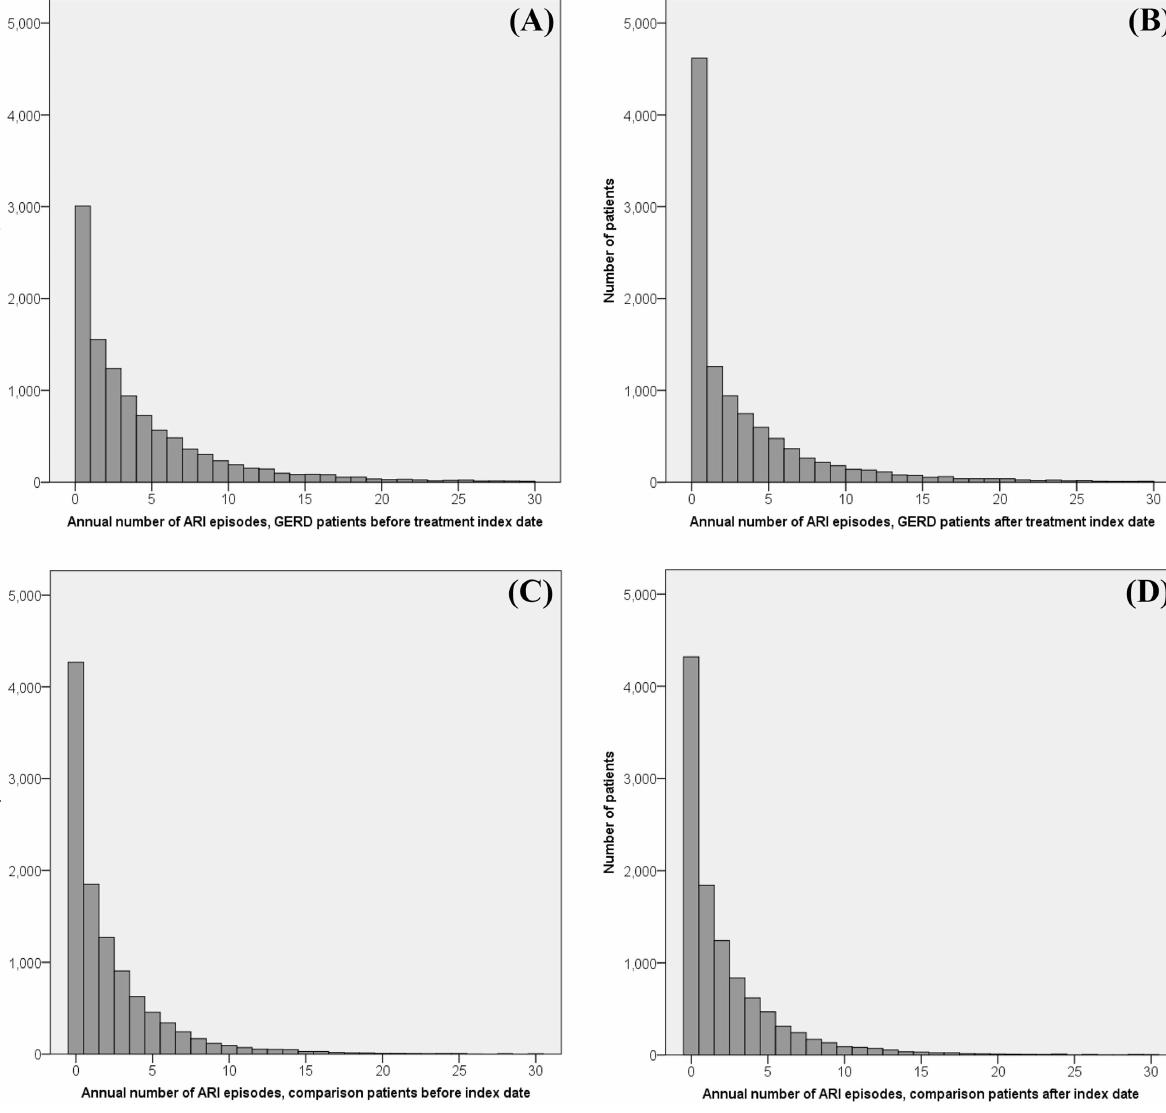
Fig 1. Distribution of patients by annual number of for acute respiratoryinfection episodes classified by patient group and study period: (A) GERD patients before the index date (B) GERD patients after the index date (C) Comparison patients before the index date (D) Comparison patients after the index